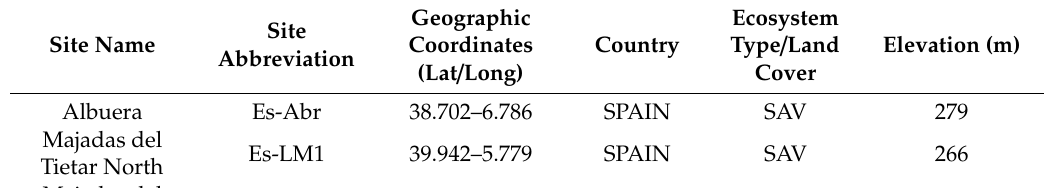
Table 1. Main characteristics of our study sites.